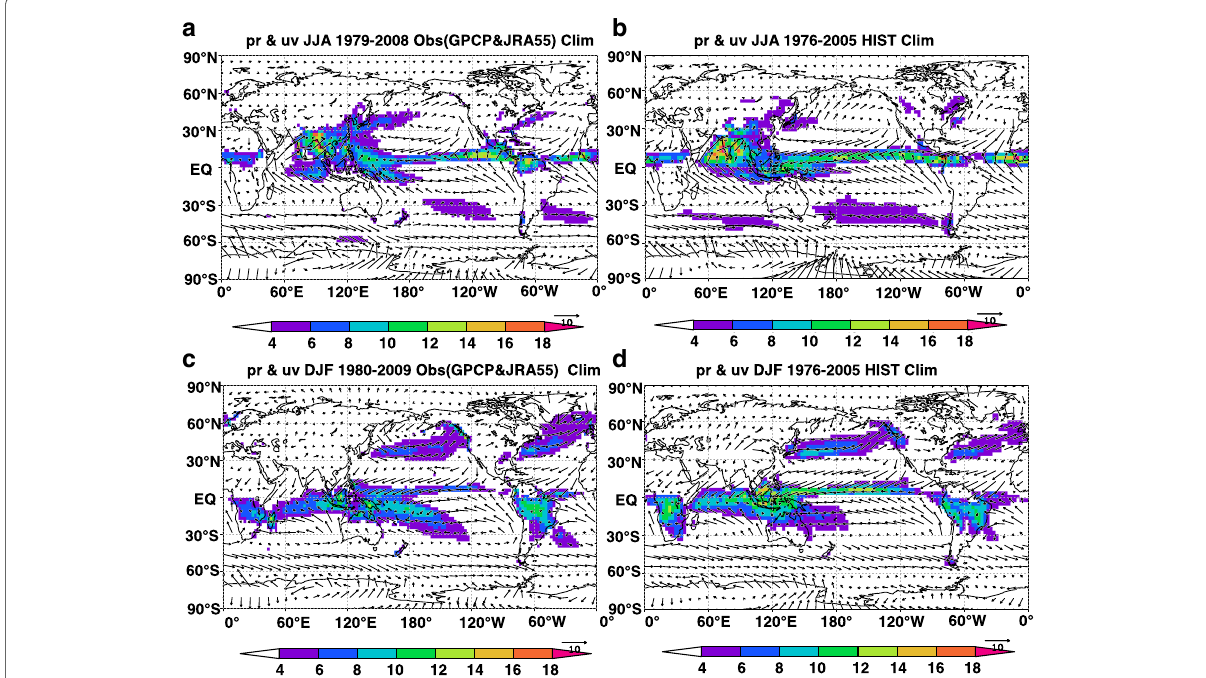
Fig. 2 Climatology in a observed and b simulated precipitation and surface winds at 10 m above the surface during June, July, and August (JJA). c and d are the same as a and b , respectively, except for December, January, and February (DJF). For the observations, the values were averaged over 30 years from 1979 to 2008, and for the HIST simulation, the values were averaged over 30 years from 1976 to 2005. For the simulated climatology, we averaged the three-ensemble